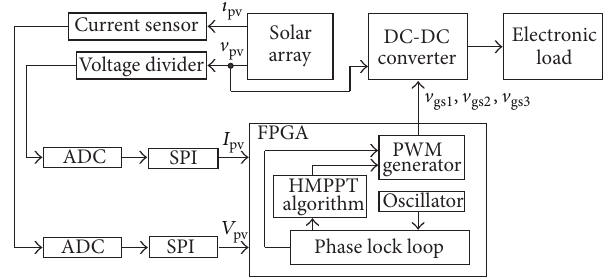
Figure 1: Overall system